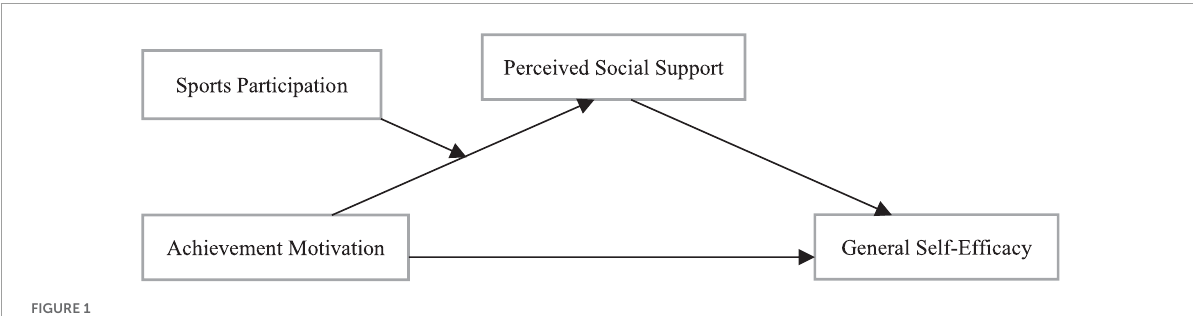
FIGURE1 Schematic diagram of hypothetical moderated mediation